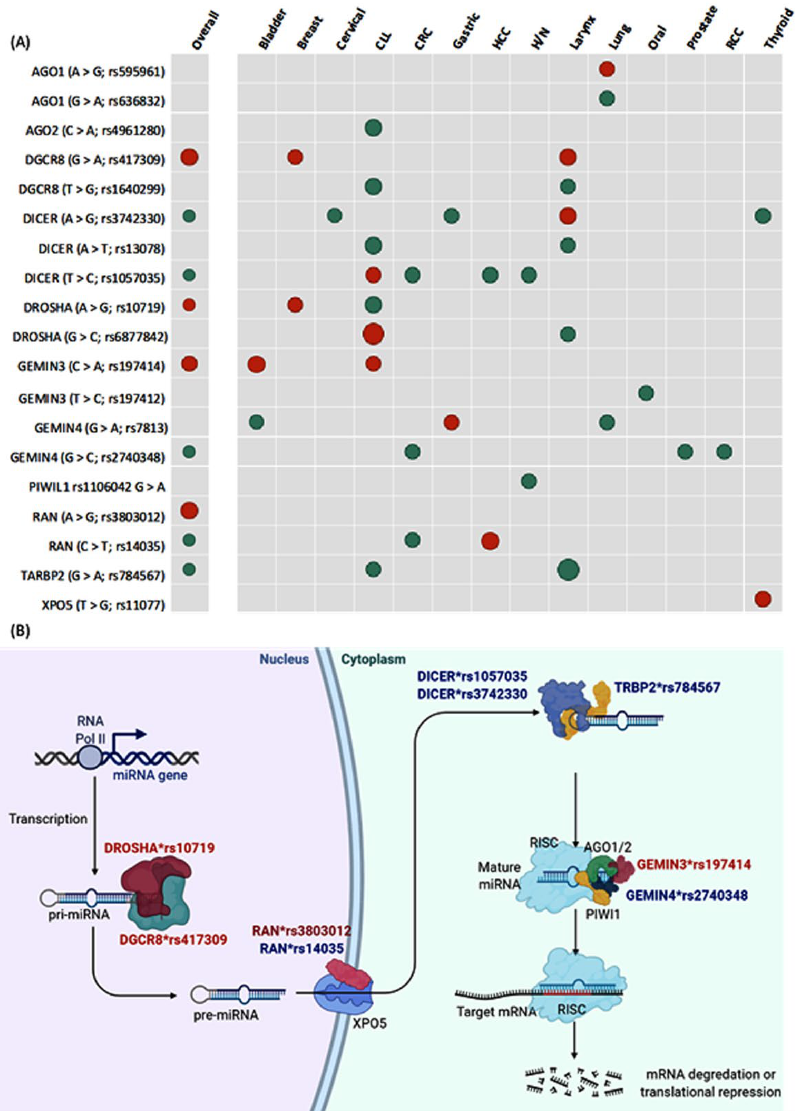
Figure 4. Pooled cancer risk of microRNA machinery gene variants. ( A ) Dot plot showing genes with significant high risk (red) and low risk (green) for cancer development. The size of the dot is proportional to the odds ratio. The matrix shows the association of combined studies of different types of cancer in addition to the data split for each type. Cancer types with insignificant results across all variants were not included in the plot. ( B ) Biogenesis of microRNA machinery pathway showing cellular localization of action for the significant genes and polymorphisms. Out of the 22 studied genetic variants, 9 SNPs were associated with cancer risk. The red gene with SNP ID is associated with higher cancer risk, while the blue gene and SNP ID conferred protection against cancer.